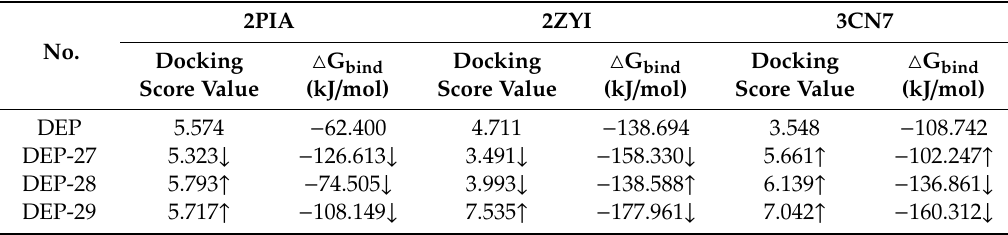
Table 7. Molecular docking scores and molecular dynamics simulation of the binding energy calculation for DEP and its derivative